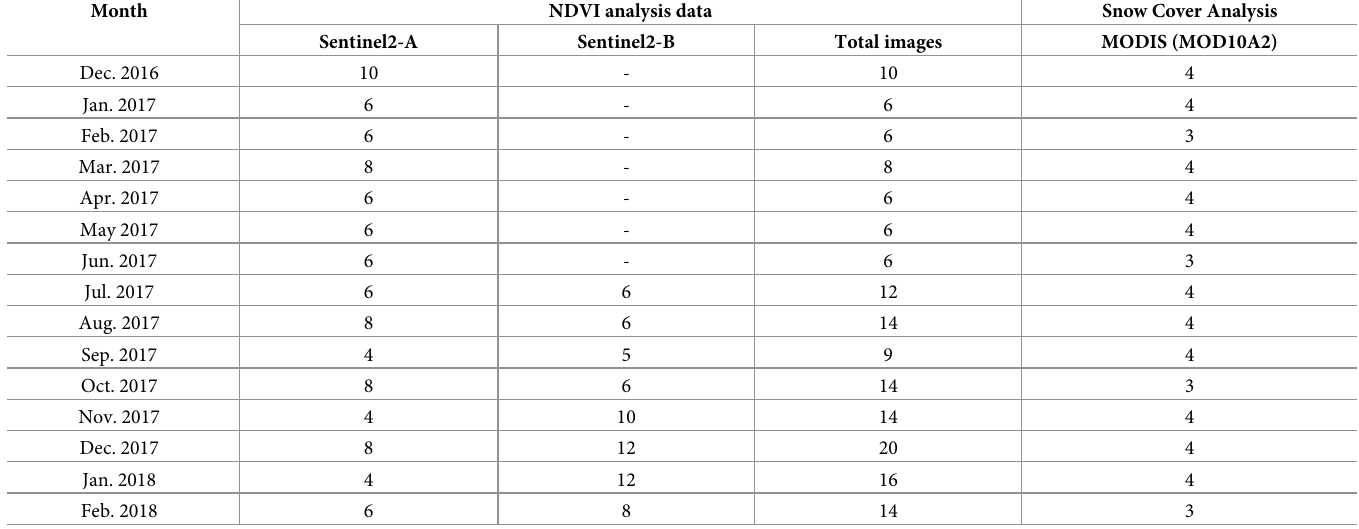
Table 1. Sentinel2 and MODIS data